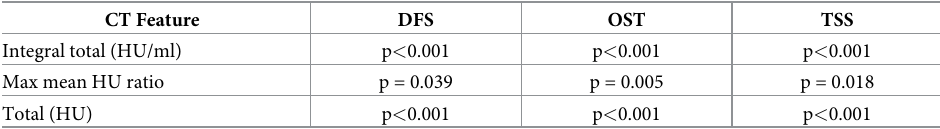
Table 5. CT features associated with outcome measures in dogs with lung